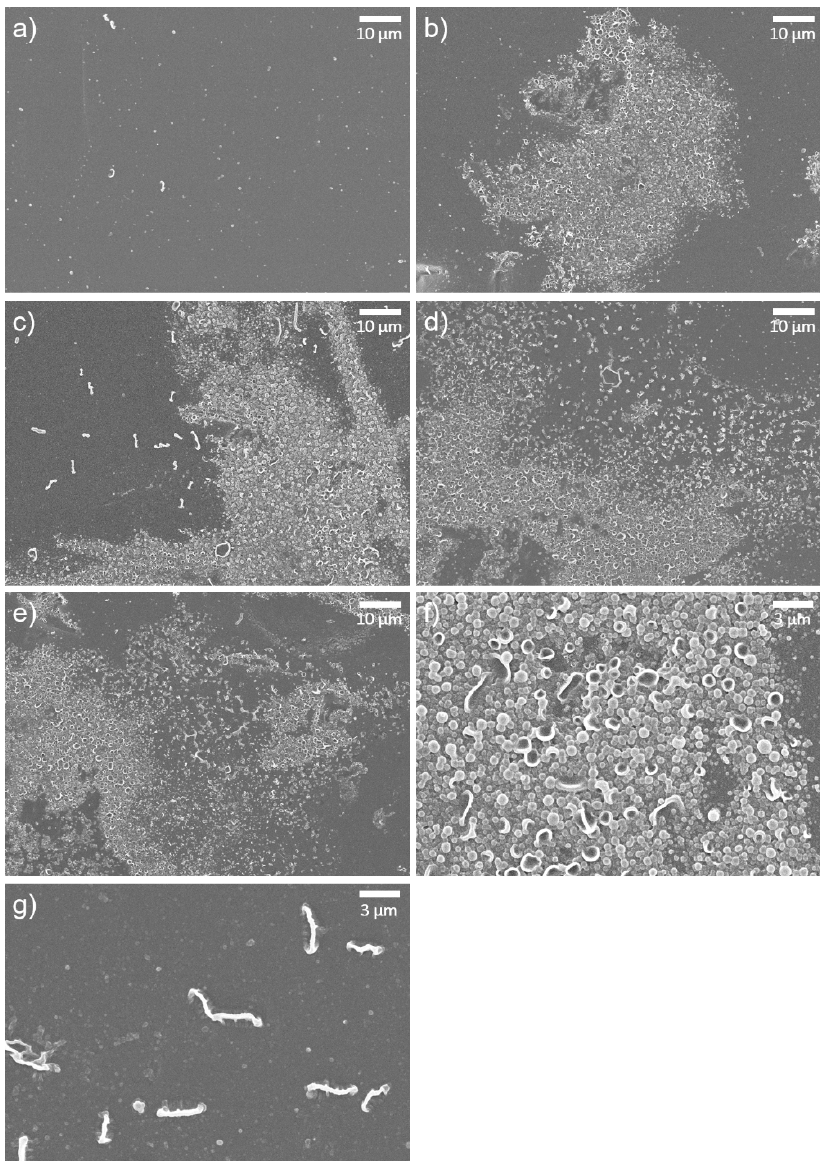
Figure 4. SEM images of ( a ) TFC, ( b ) GONs-TFC (20 ppm), ( c ) GONs-TFC (40 ppm), ( d ) o-SWNTs- TFC (20 ppm), and ( e ) o-SWNTs-TFC (40 ppm) membranes at 3000× magnification, ( f ) bumps and ( g ) ridges of a GONs-TFC membrane (40 ppm) at 10,000× magnification. These figures show the surface of the membranes before exposure to acid solution.